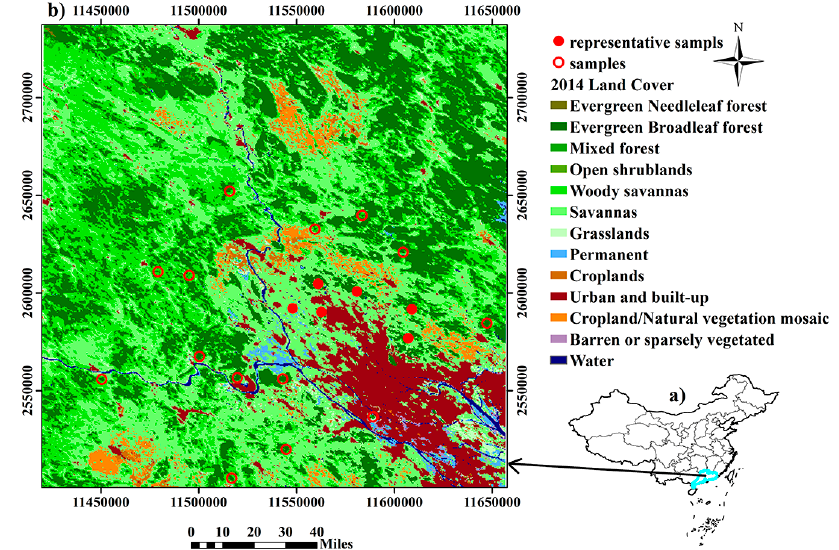
Figure 1. Location of the study area: ( a ) map of China with highlight of study area; ( b ) 500 m spatial resolution land cover map from the MODIS Land Cover Type Product (MCD12) showing the spatial distribution of sample plots (red solid plots are representative samples).